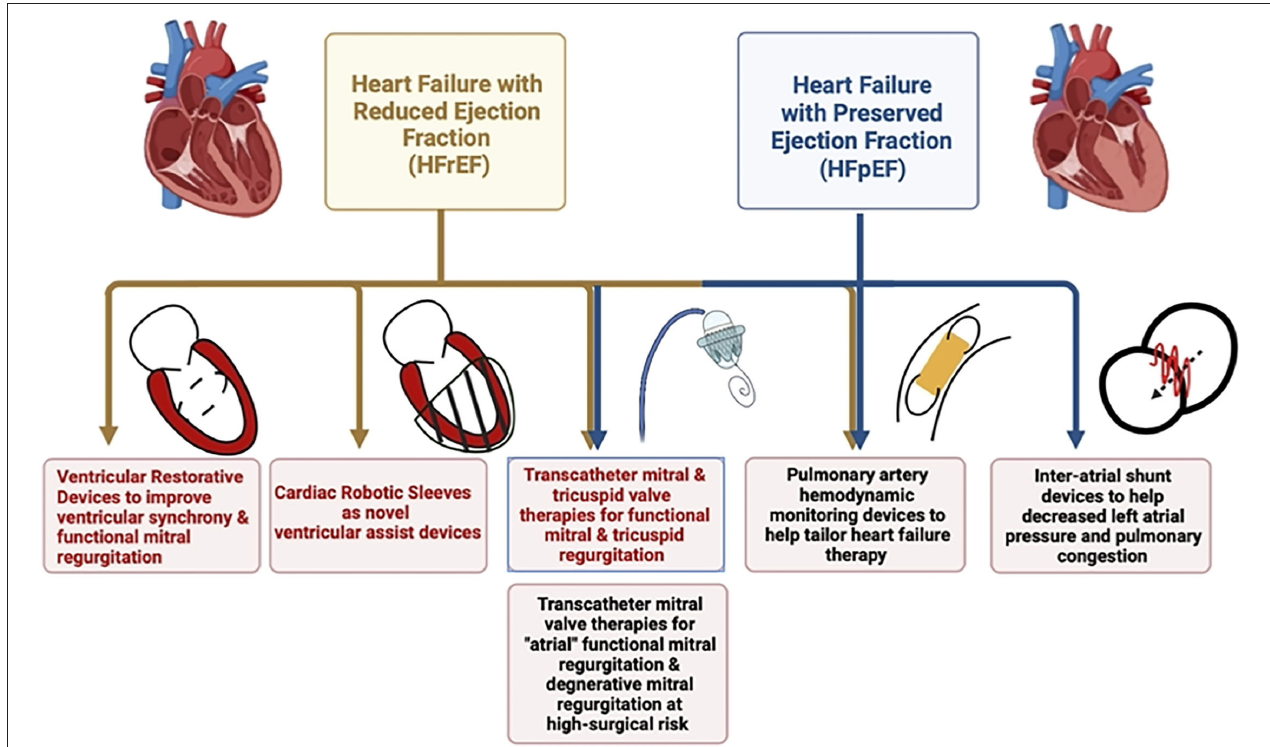
FIGURE 1 | Schematic diagram highlighting the role of different structural interventions in heart failure with reduced and preserved ejection